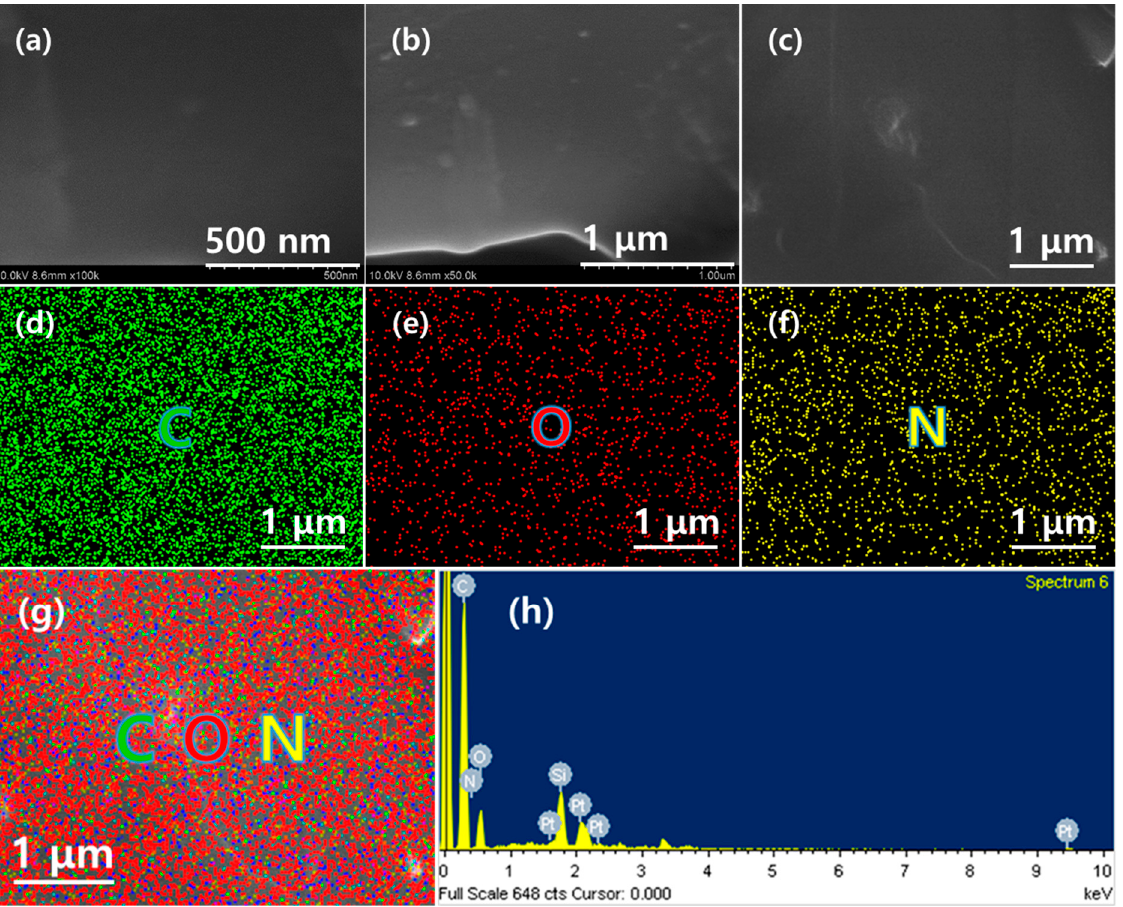
Figure 1. ( a – c ) FE-SEM images of functionalized carbon nanodots (F-CNDs; ( d – g ) EDX elemental mapping images of F-CNDs ( d ) carbon, ( e ) oxygen, ( f ) nitrogen, and ( g ) overlapping image showing all elements; ( h ) EDX spectrum of F-CNDs.